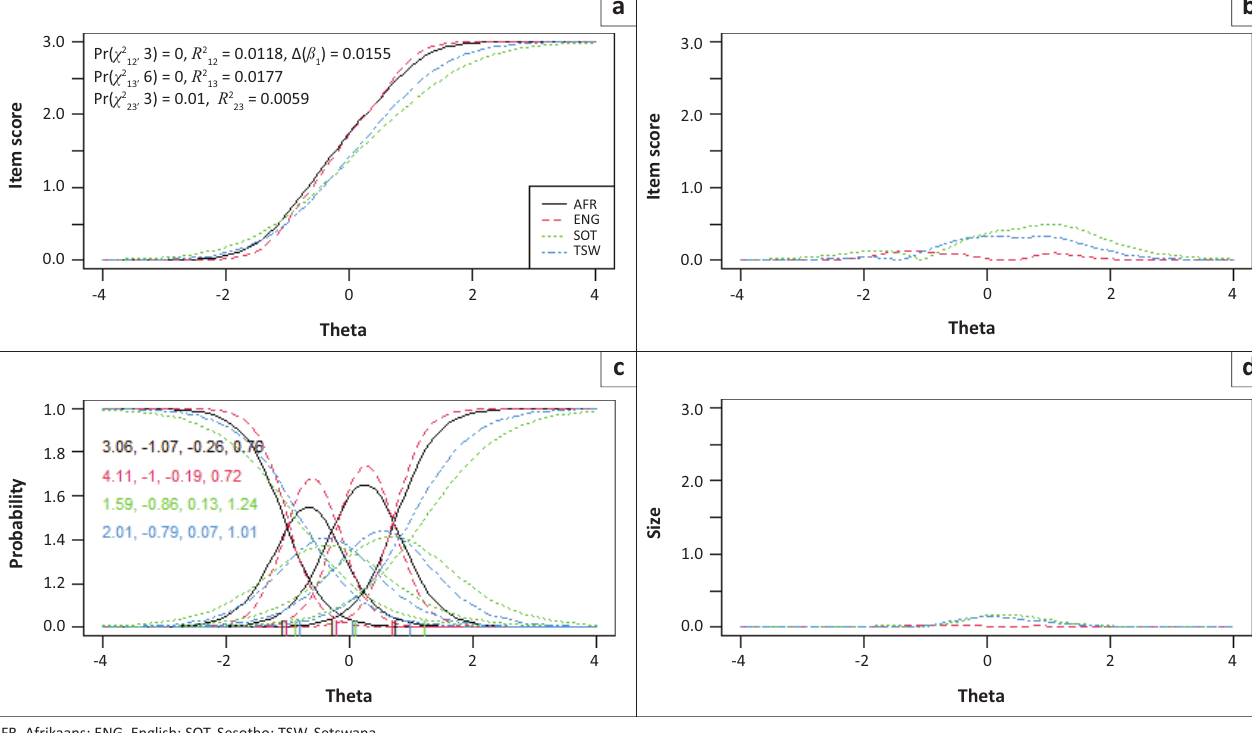
FIGURE 2: Graphical display of Item 3, which shows uniform and non-uniform differential item functioning with respect to language groups. (a) Items True Score Functions - item 3; (b) differences in items True Score Functions; (c) Item Response Functions; (d) Impact (weighed by